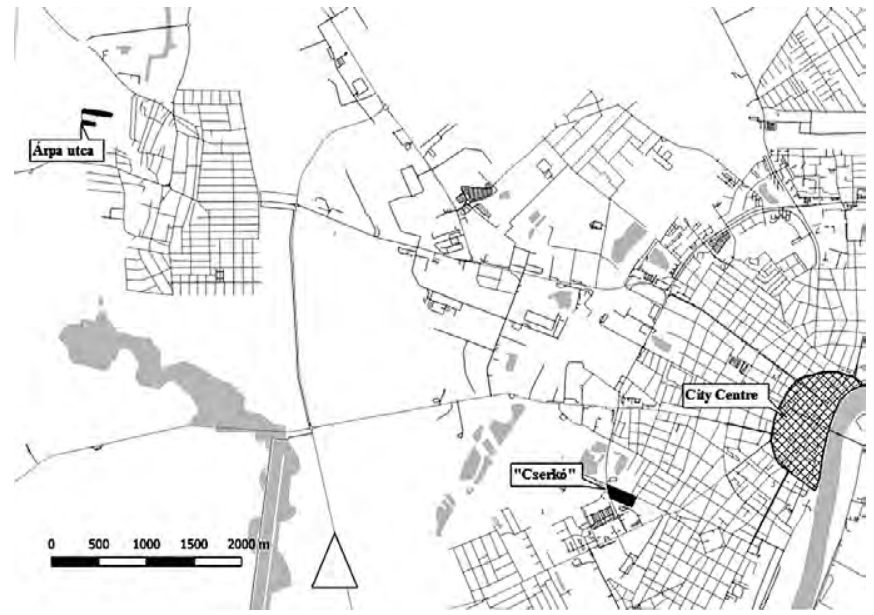
Figure 1. Segregated Roma neighbourhoods within the city of Szeged,